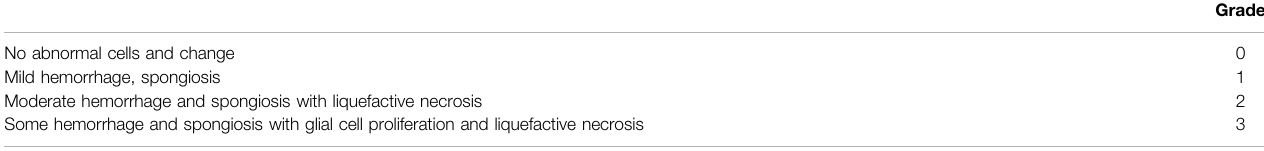
TABLE 4 | A semi-quantitative grading system according to Ustun et al. (2014). Spinal cord segment was examined for hemorrhage, spongiosis and liquefactive necrosis semi-quantatively for histopathological changes.